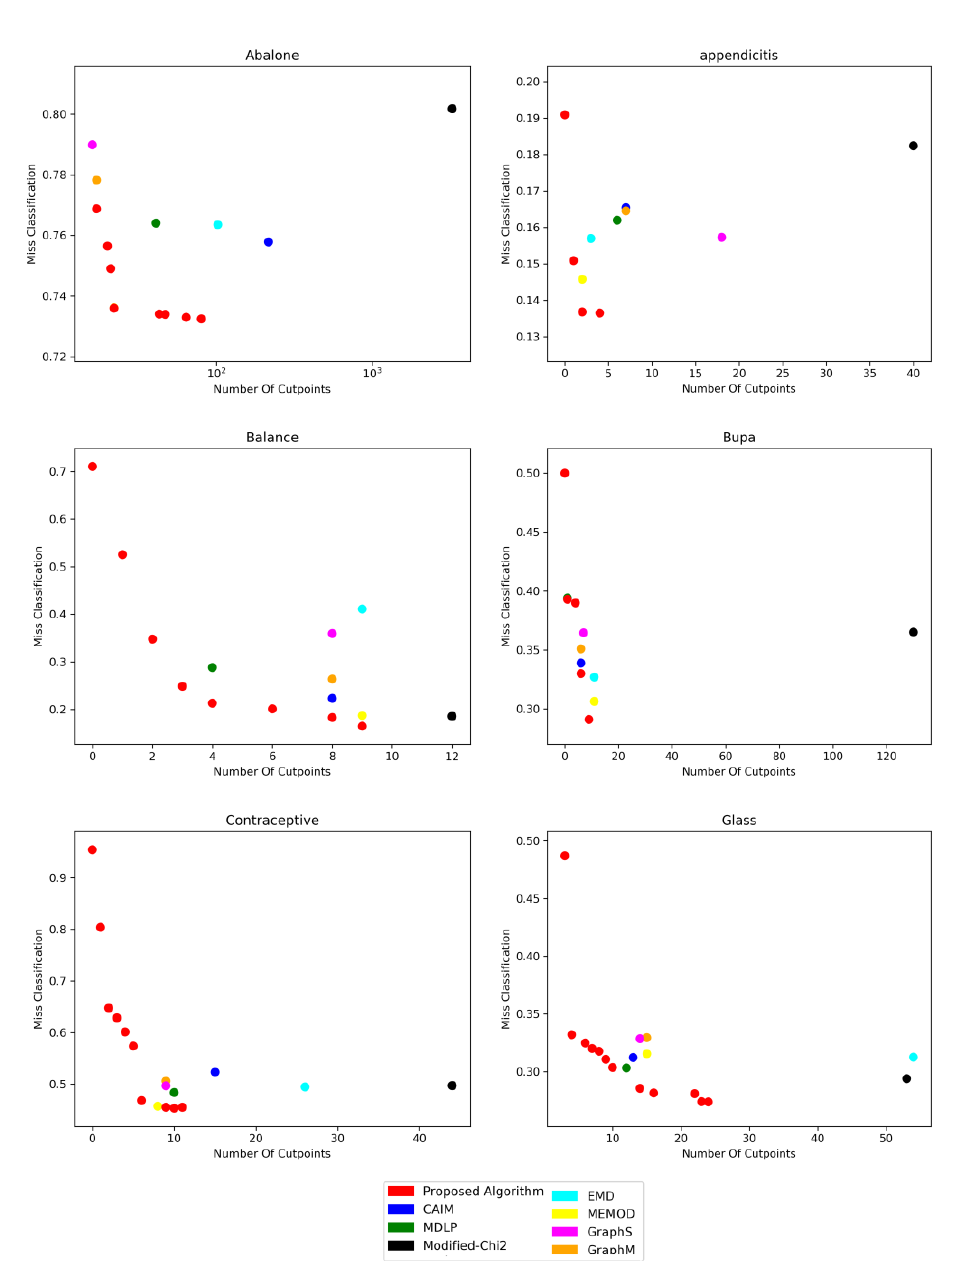
Figure 1. Projection of non-dominated solutions obtained by the proposed algorithm for the considered datasets